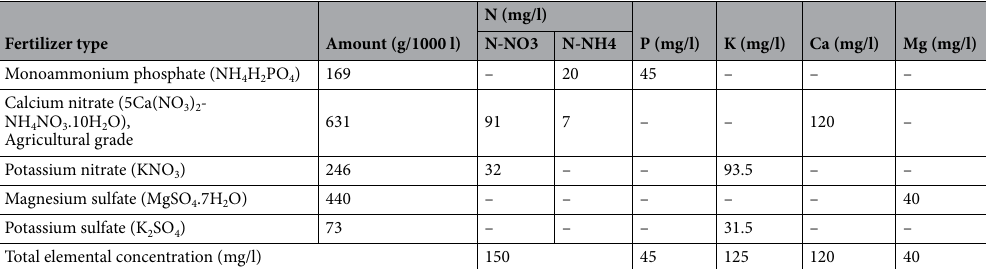
Table 1. Fertilizer type and amount used to make 1000 L of nutrient